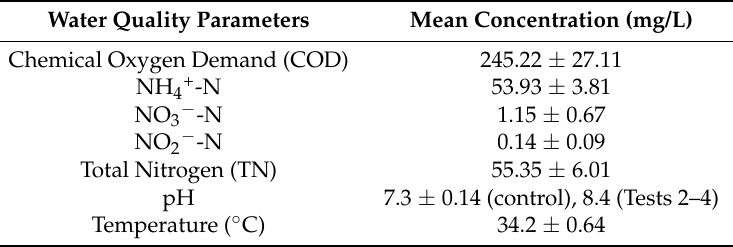
Figure 4. Scanning electron microscope (SEM) images of filling medium (sand) in the CRI columns after 70 days of operation. ( a ) blank filling medium; ( b – e ) filling medium (formed with biofilm) of Tests 1–4. Table 1. Water quality parameters of